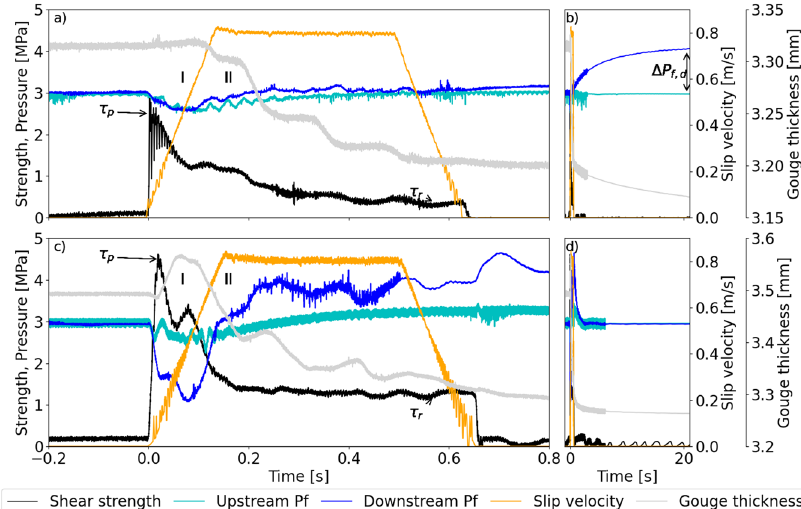
Fig. 2 Seismic mechanical behaviour of pressurised fault gouges. Anatomy of the seismic velocity slip pulse in P ā paku thrust footwall material (experiment s1737) and Carrara marble gouge (experiment s1823). Slip velocity, thickness, shear strength and pore fl uid pressure measured on the downstream and upstream side are presented versus time. P ā paku thrust materials. a At the onset of slip (I), slip velocity increases to the target value of 0.8 m/s, pore fl uid pressure decreases right after the achievement of the peak strength ( τ p ). Afterwards (II), shear strength decreases to the residual value ( τ ), while pore fl uid pressure increases (faster downstream than upstream). b At the end of slip pulse, pore fl uid pressure gradually increases in the r downstream side until it achieves a maximum value ( Δ P f ). Carrara marble gouge. c At the onset of slip (I), slip velocity increases to the target value of 0.8 m/s, pore fl uid pressure decreases during the achievement of the peak strength ( τ ). Afterwards (II), shear strength decreases to the residual value ( τ ), p r while pore fl uid pressure increases (faster downstream than upstream). d At the end of the slip pulse, pore fl uid pressure is equilibrated in the whole system after ca. 5